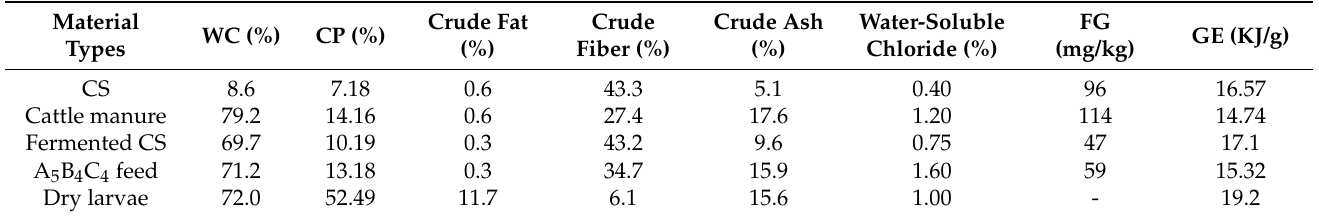
Table 8. Key nutritional indicators for raw materials, fermented materials, and dry larvae as feed ingredients.